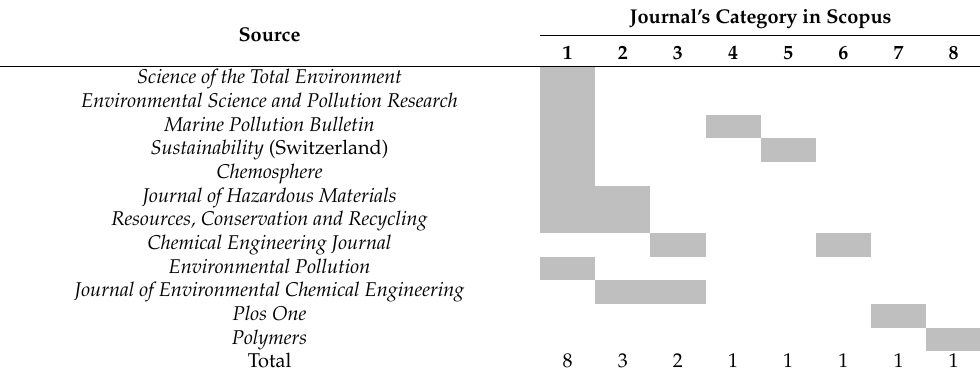
Table 2. Categories of sources leading the rankings.